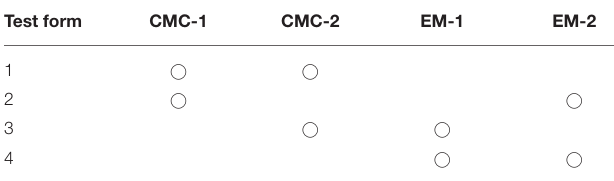
TABLE 1 | Test form